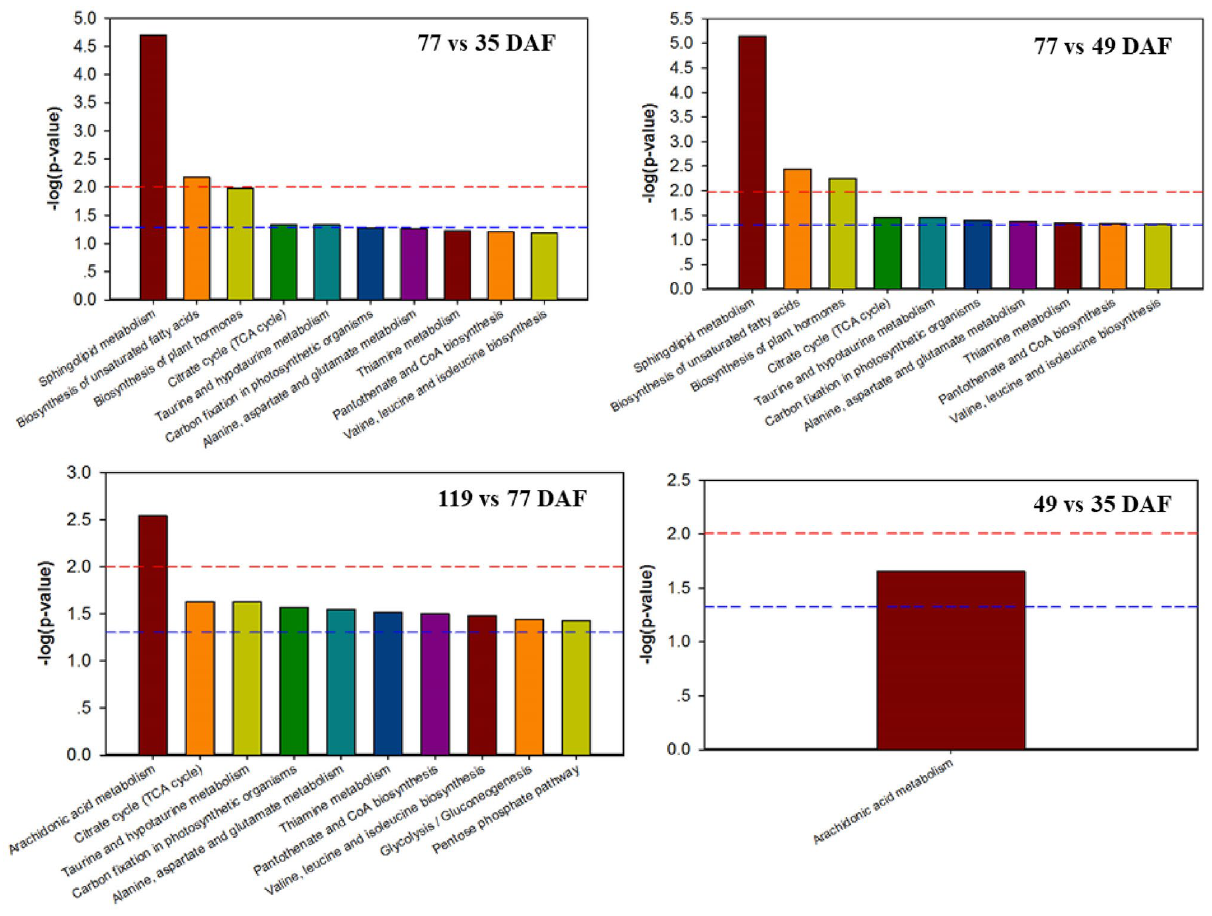
Figure 4. The 10 KEGG pathways most significantly overenriched in the lipid components differentially abundant during kernel development in Paeonia ostii